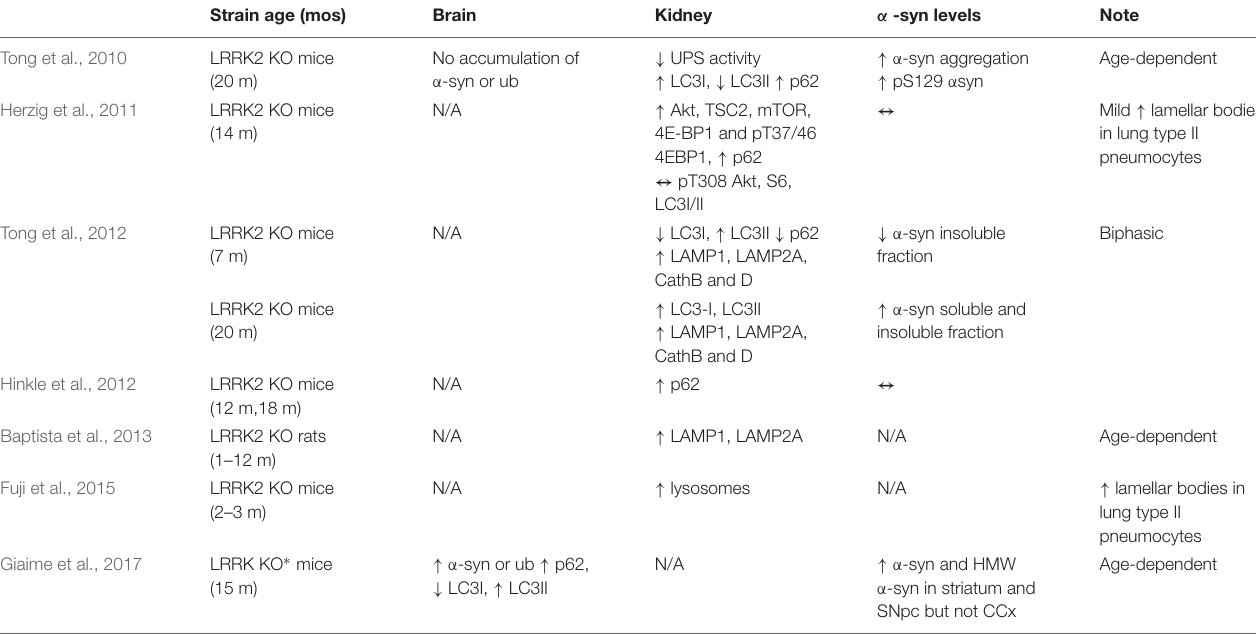
TABLE 2 | Changes in autosomal-lysosomal pathways in LRRK2 KO mice and rats in vivo . Strain age (mos) Brain Kidney α -syn